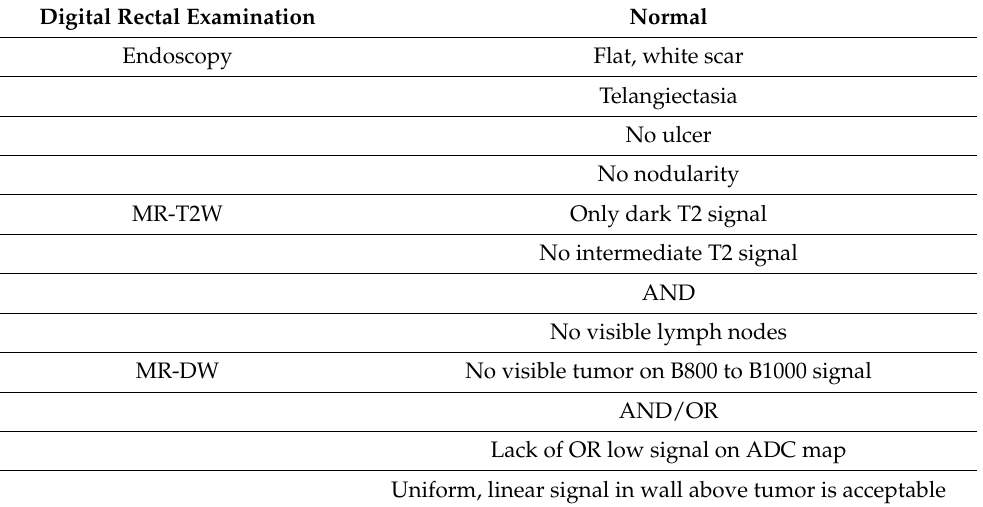
Table 1. Definition of complete clinical remission following TNT (Memorial Sloan Kettering Regres- sion Scheme).